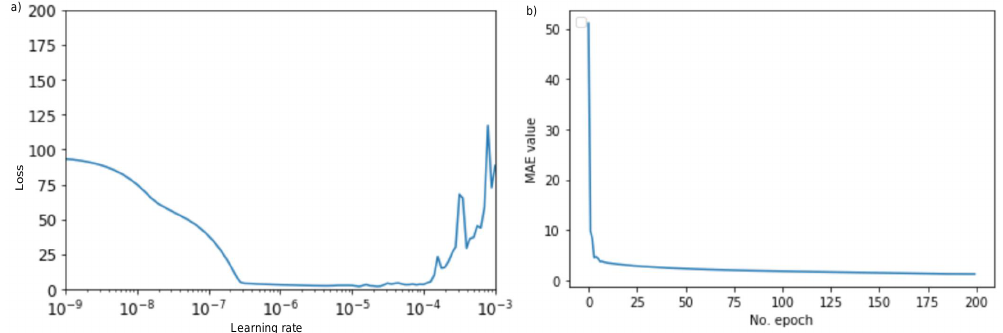
Figure 8. ( a ) The loss function of the CNN-LSTM with varying learning rate and ( b ) the loss function with the best learning rate chosen in the previous step which decreases up to 200